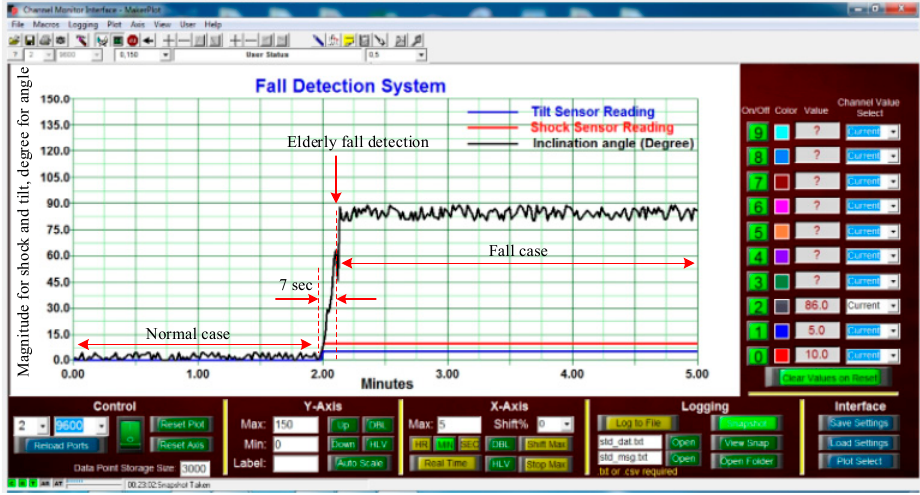
Figure 14. Plot of tilt, shock, and angle measurements based on MakerPlot software.